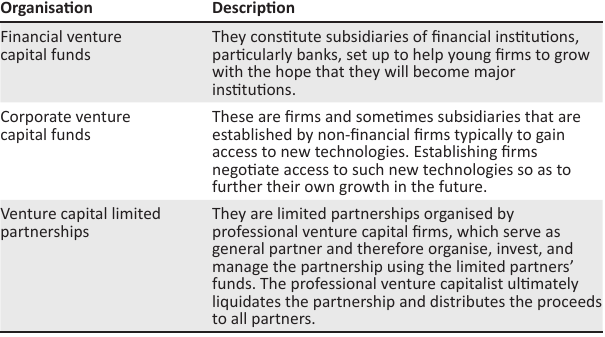
TABLE 2: Organisation of institutional venture capital investors in South Africa.